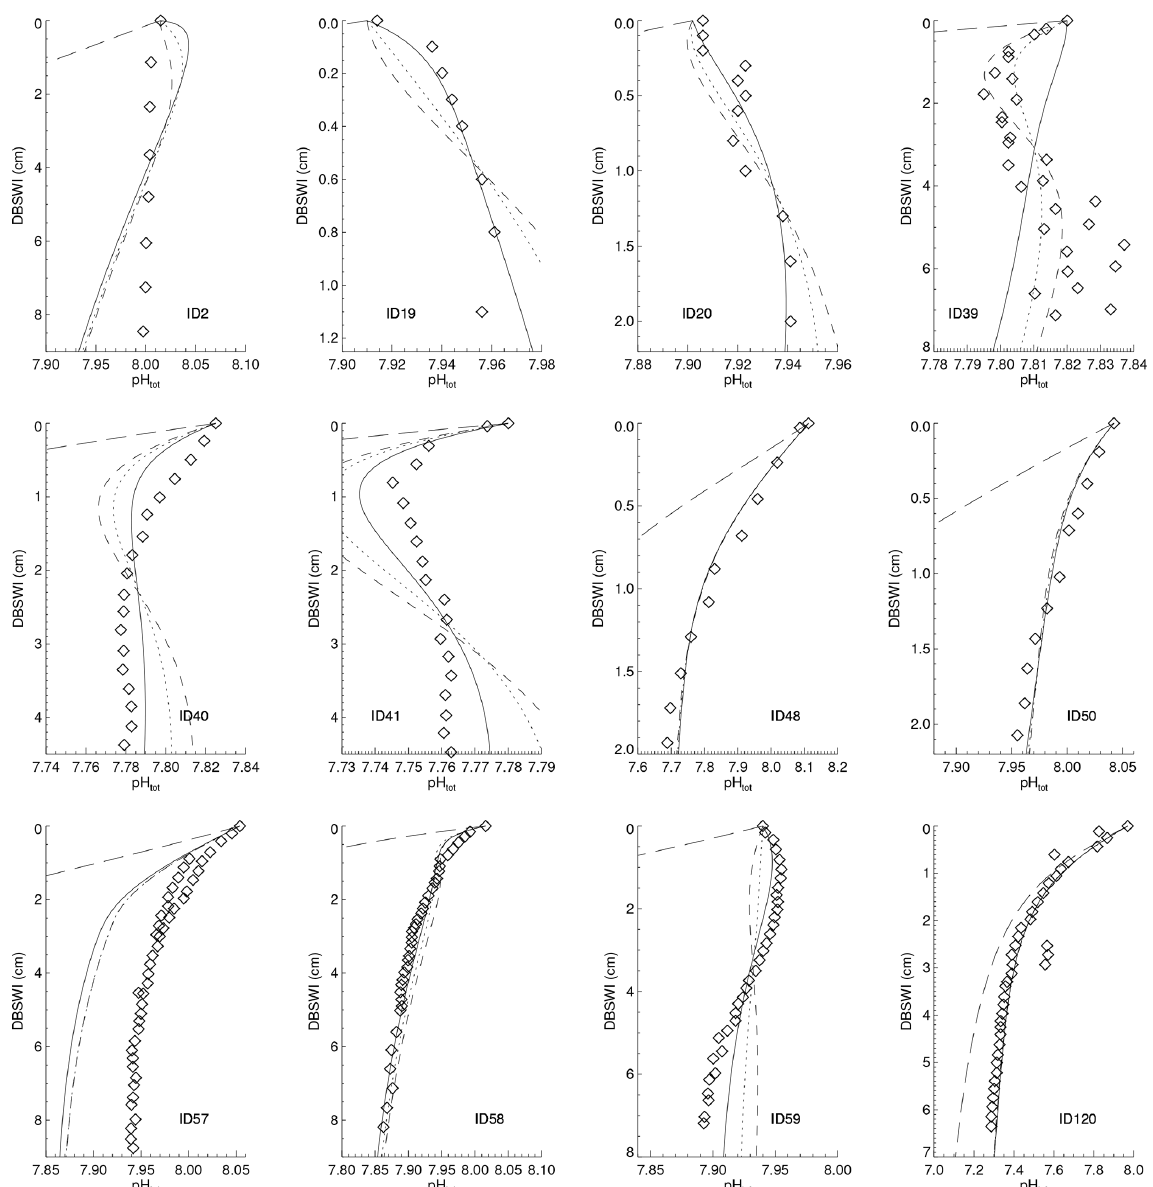
Figure 7. The pH profiles with data-constrained surface sediment %Calcite. Lines are as follows: long dashed – no calcite dissolution; full – calcite dissolution kinetics of order 4.5; dotted – order 2; short dashes – order 1 (linear). Please note that the n = 4 . 5 fit at site 2 and all the fits for sites 19 and 20 require calcite mass fractions in the deposition fluxes exceeding 100% (between 140% and 730%).